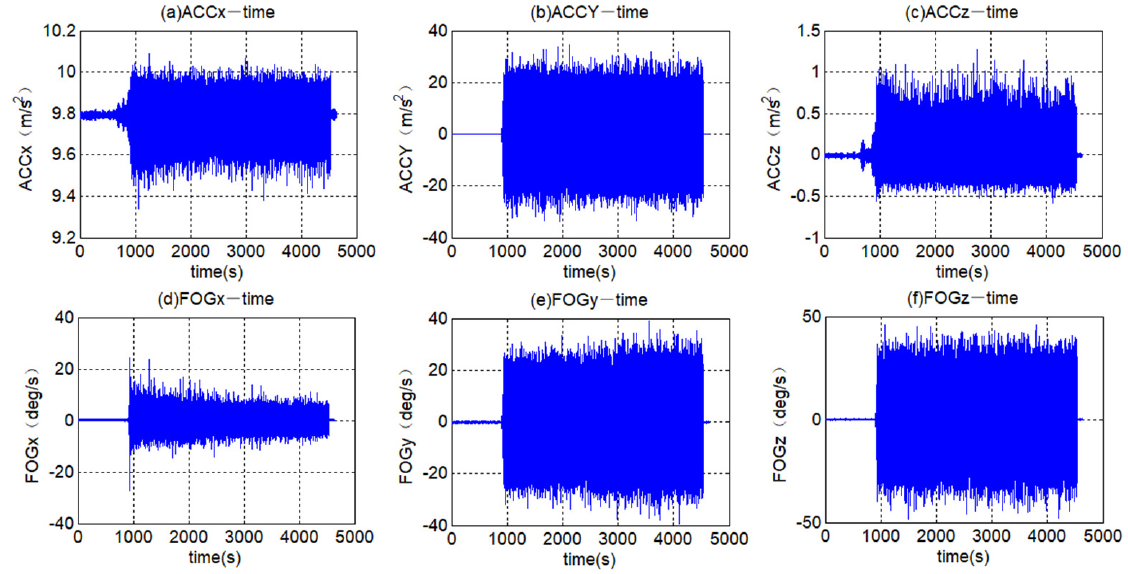
Figure 14. The original data of the FOG-based MWD in the vibration